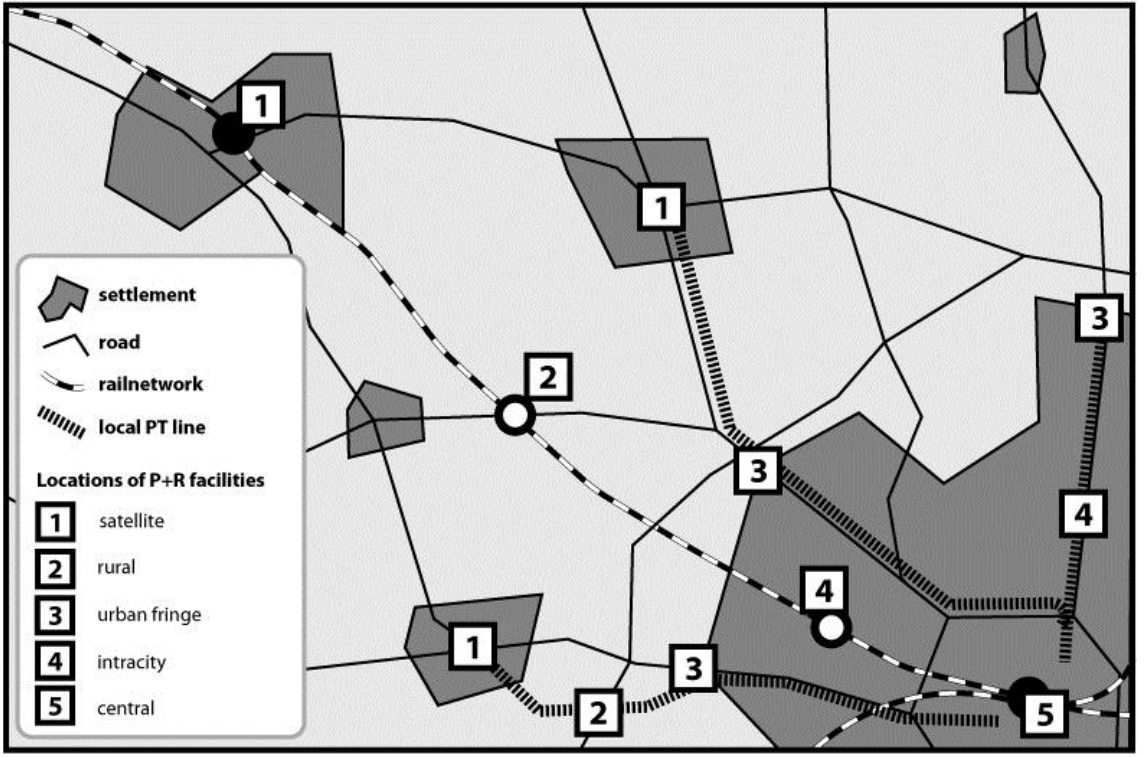
Figure 1. Five types of P+R based on their geographical